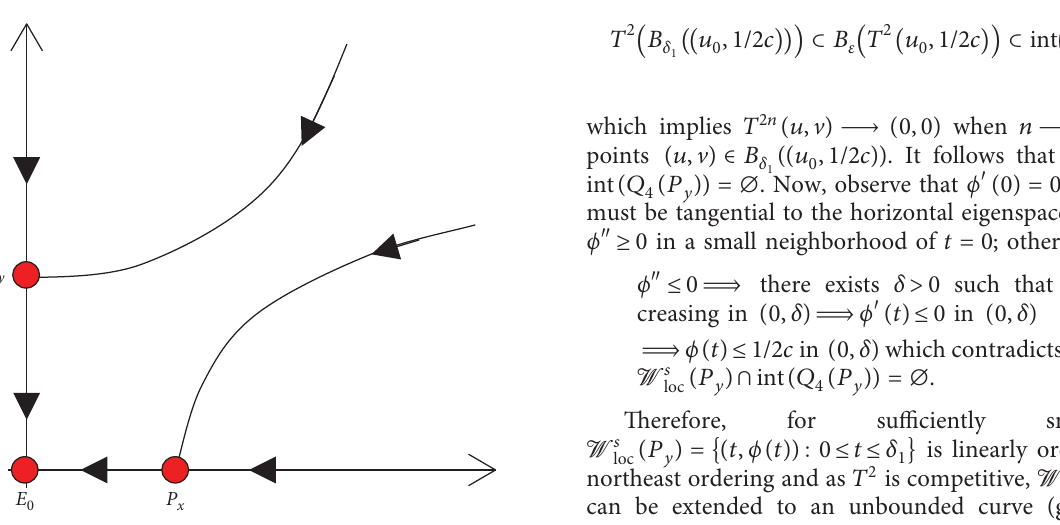
Figure 5: Visualization of global dynamics of Theorem 7 for 4 fc �